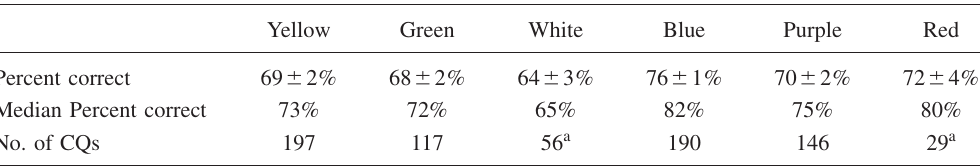
TABLE III. Percent of students getting the clicker question correct on average. Yellow Green White